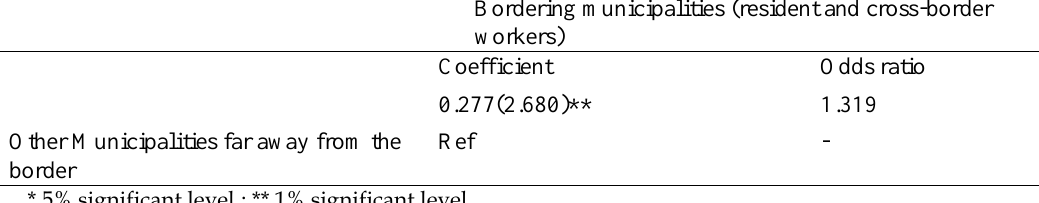
Bordering municipalities (resident and cross-border workers)